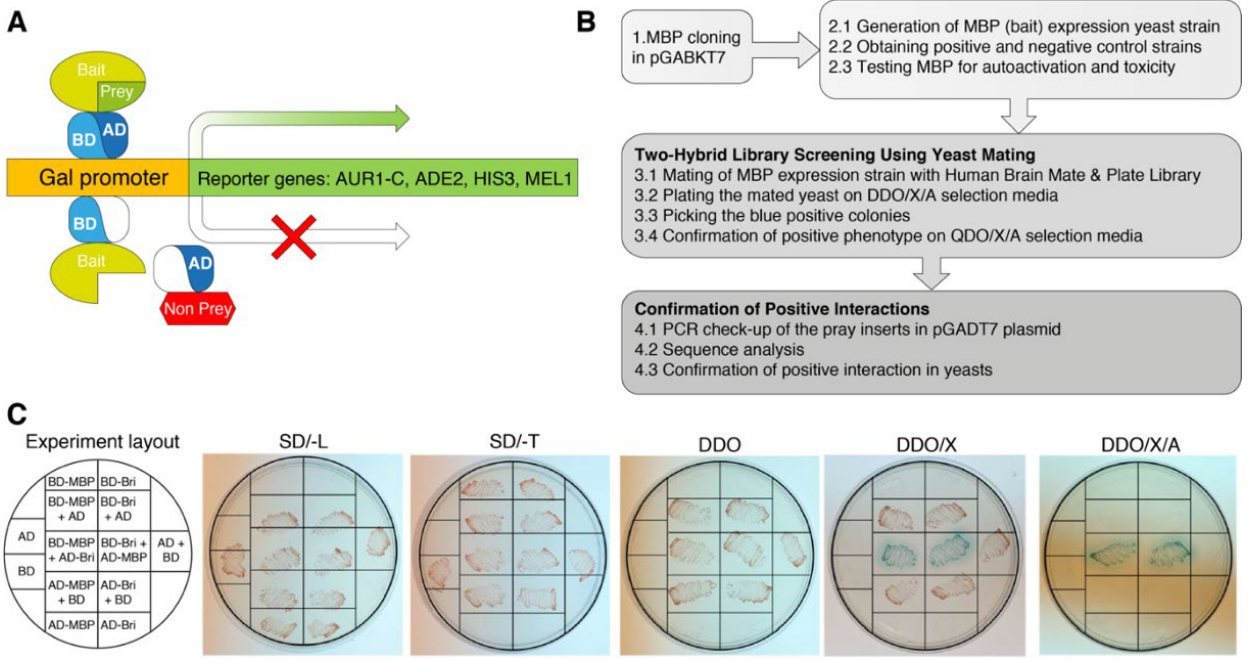
Figure 1. Experiment schematics. ( A ) Principle of a two-hybrid yeast system for the detection of protein-protein interactions. One protein is expressed as a GAL4BD fusion protein, and another protein is expressed as a GAL4AD fusion protein. When they interact, BD and AD are brought into proximity and activate the transcription of the reporter genes AUR1-C , ADE2 , HIS3 , and MEL1 , allowing selection. ( B ) Flow chart of procedures for two-hybrid identification of proteins interacting with MBP. ( C ) Validation assay in yeasts to confirm MBP-Bri23R interaction. The transformed clones were streaked on the plates with the selection media. The detailed scheme of the validation assay is provided in Supplementary Figure